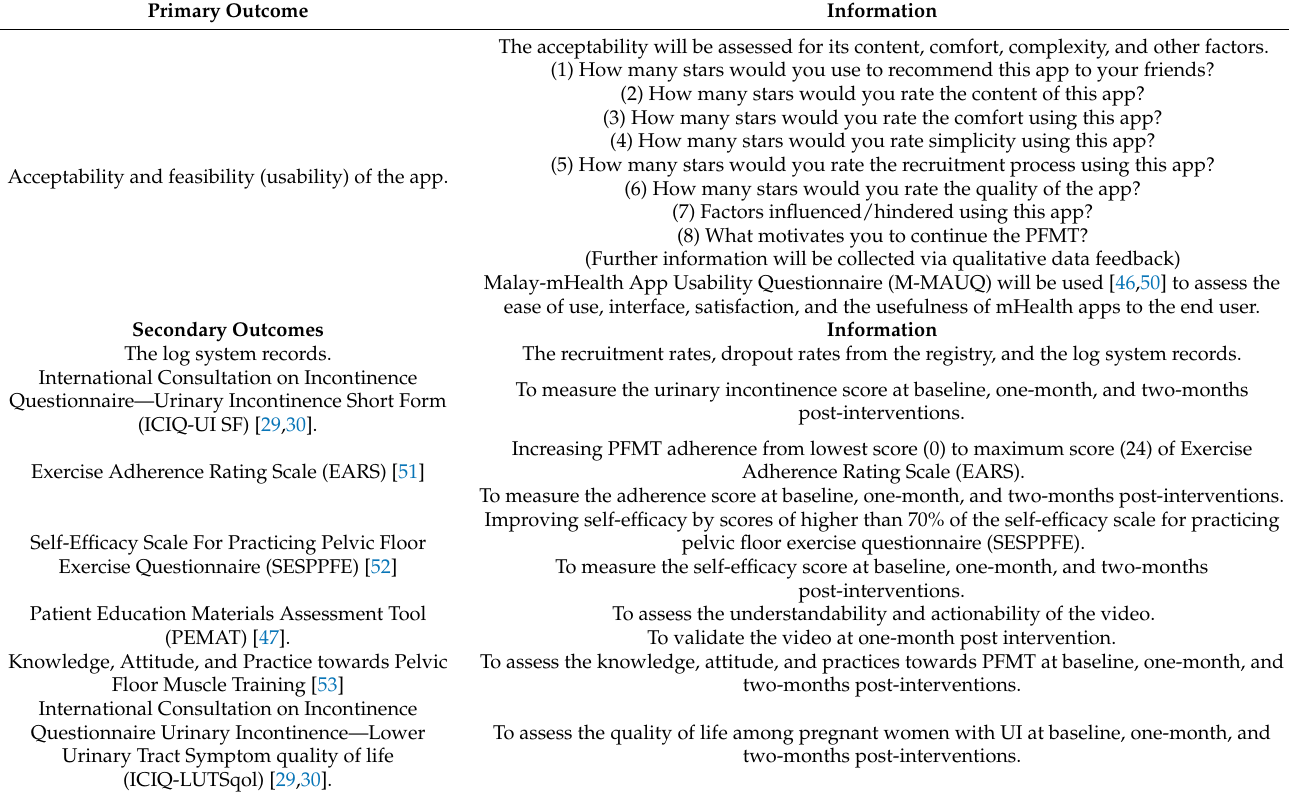
Table 1. Study outcomes of the KEPT-app